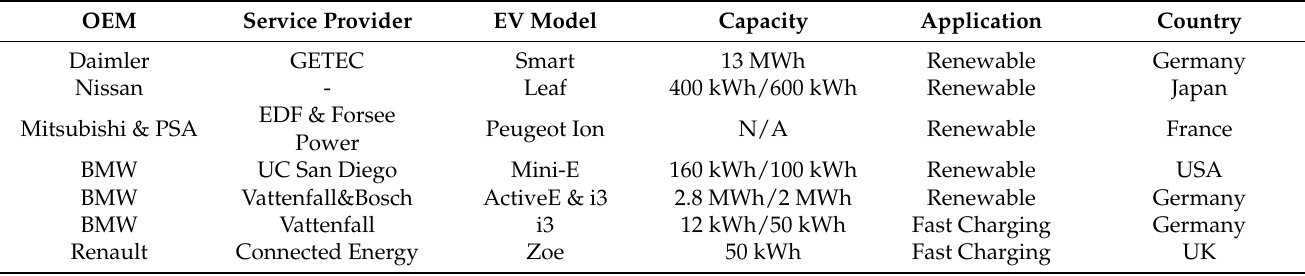
Table 4. Examples of battery second-life pilot and commercial projects, edited from